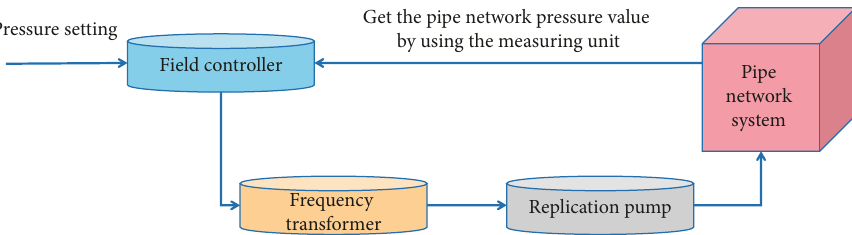
Figure 4: Automatic control of the water supply system of a heat supply